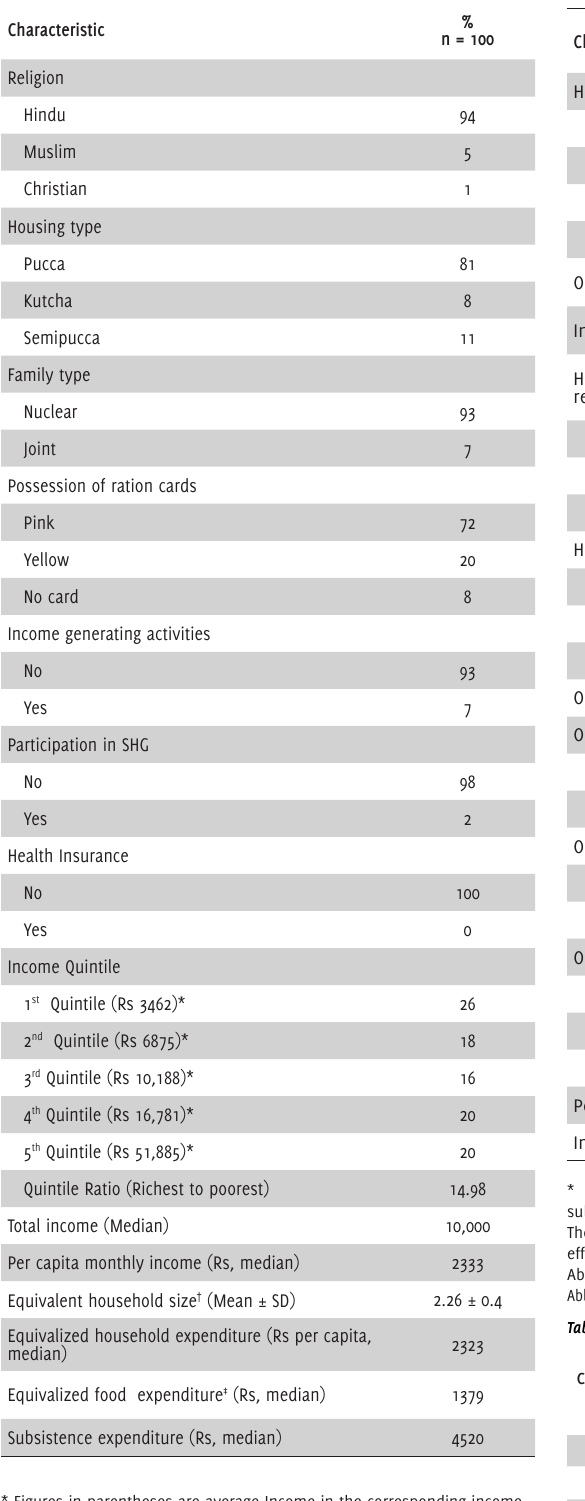
Table 1. Socio-demographic characteristics of the study